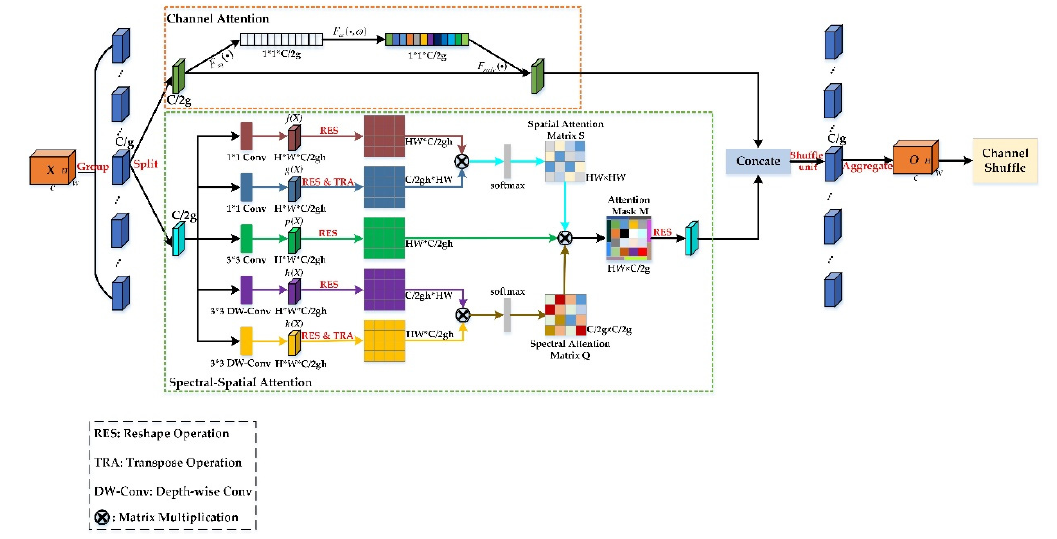
Figure 2. The schematic diagram of SSAM.